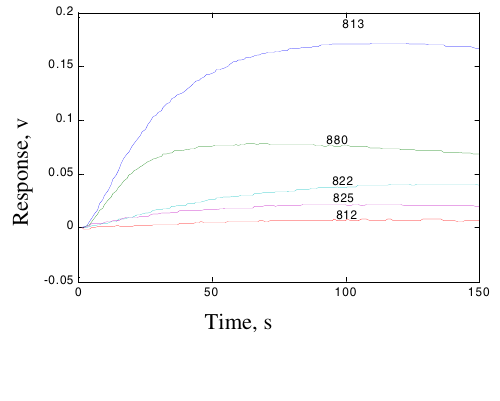
Figure 2. Typical response curve for the gas sensor array